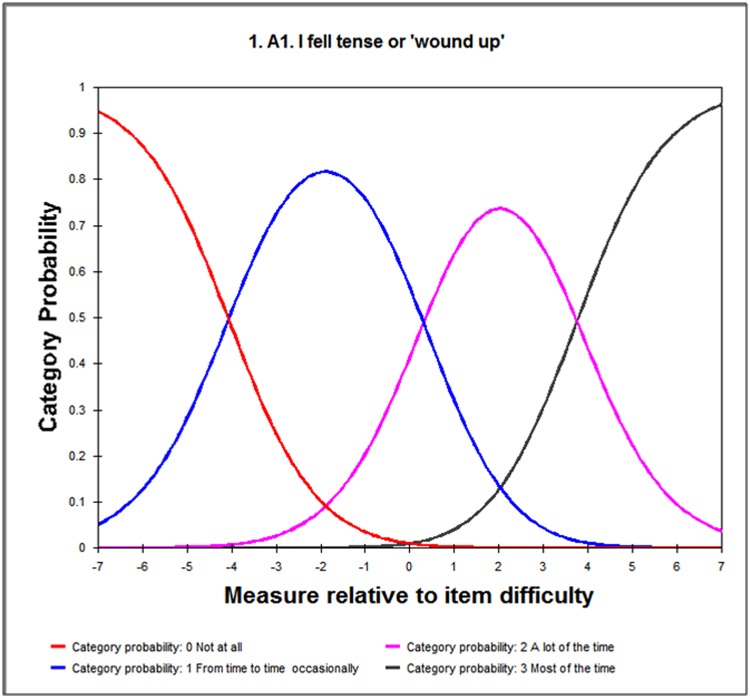
Example of the category probability curves: HADS-A1.